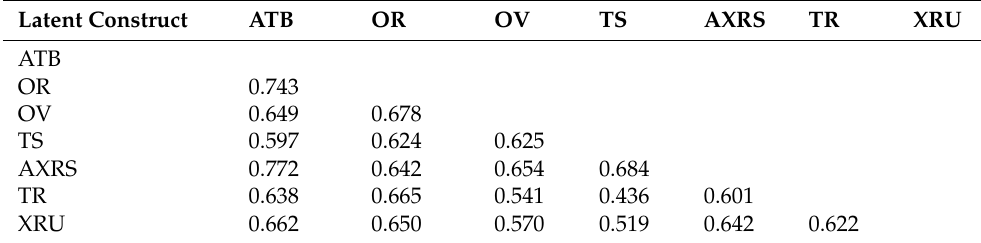
Table 4. Hetero trait–mono trait